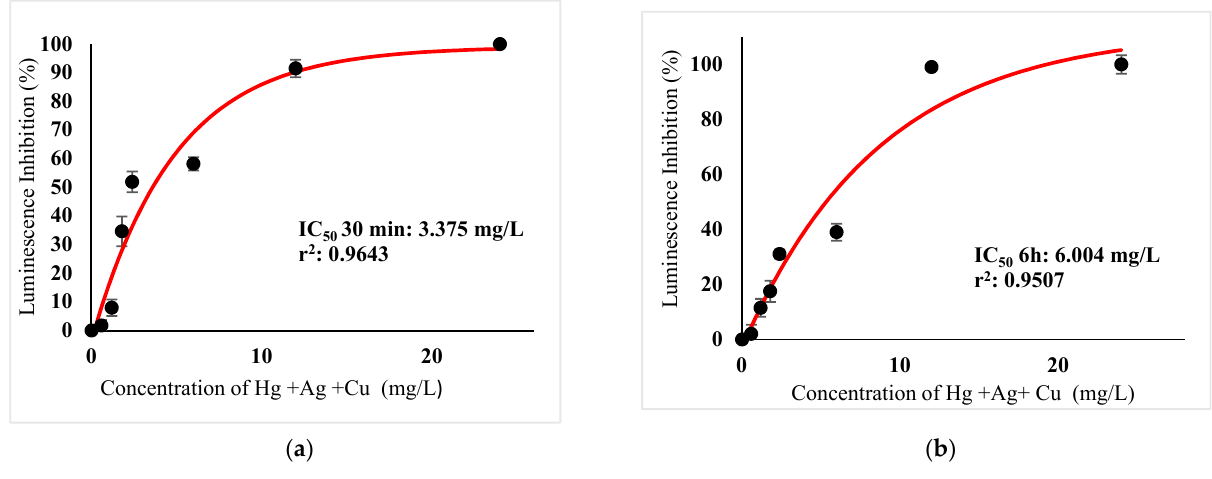
Figure 11. ( a ) Acute and ( b ) Chronic toxicity of mixture Hg 2+ + Ag + + Cu 2+ in the concentration ratio of 1:1:1 on luminescence inhibition of Photobacterium sp.NAA-MIE. Data represent mean ± SD, n = 3.